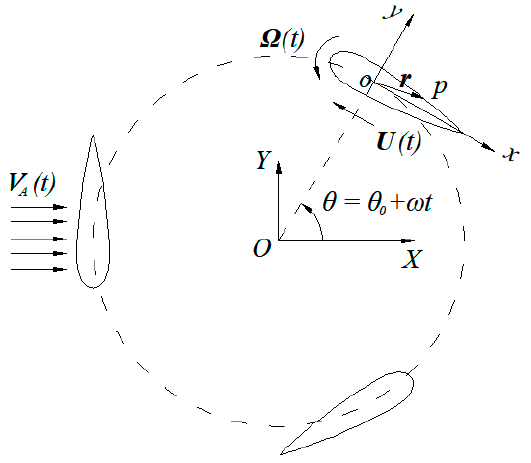
Figure 2. Coordinate system and blade motion.